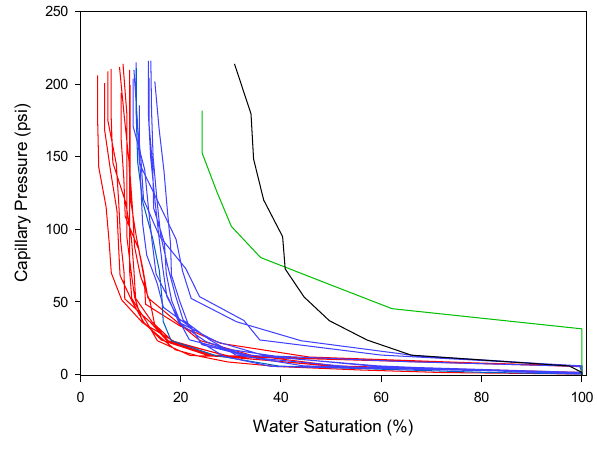
Fig. 3 Separation of capillary pressure curves for different rock